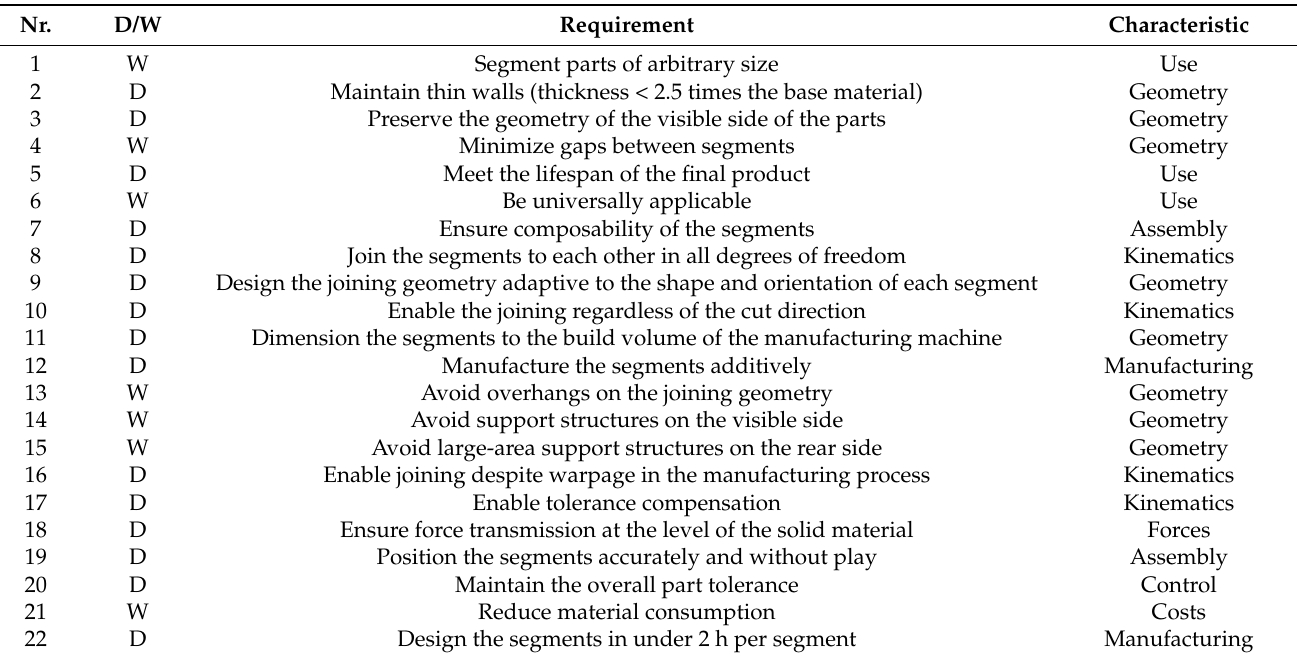
Table 1. Requirement list in order of definition in Section